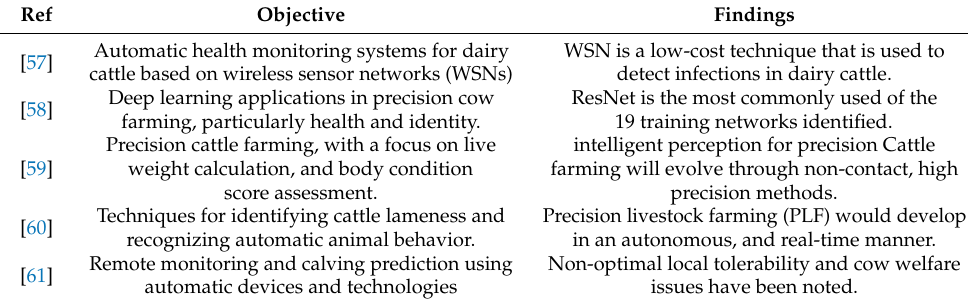
Table 3. Comparison of the previous studies of cattle health